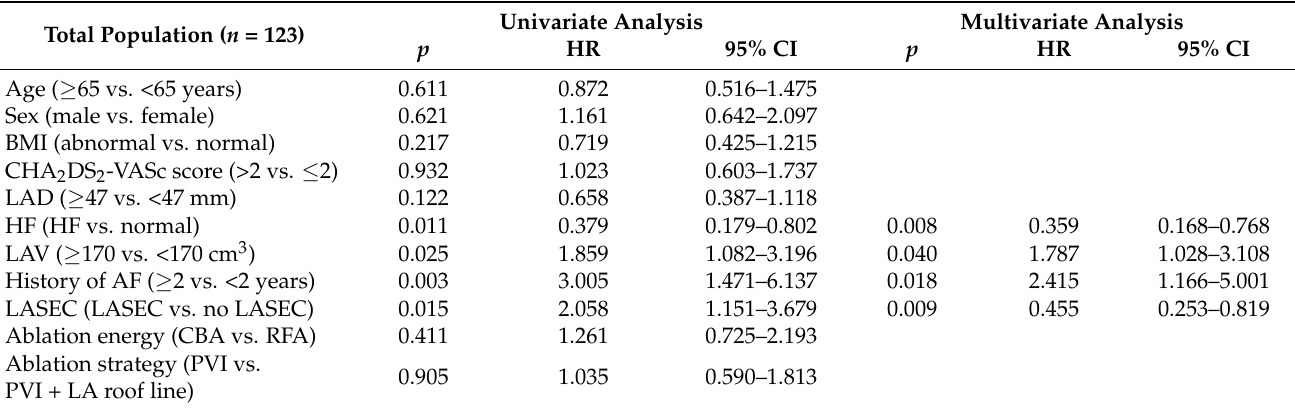
Table 4. Univariate and multivariate Cox regression analysis of freedom from AF/AT recurrence-free survival (time to AF/AT recurrence is the dependent variable).